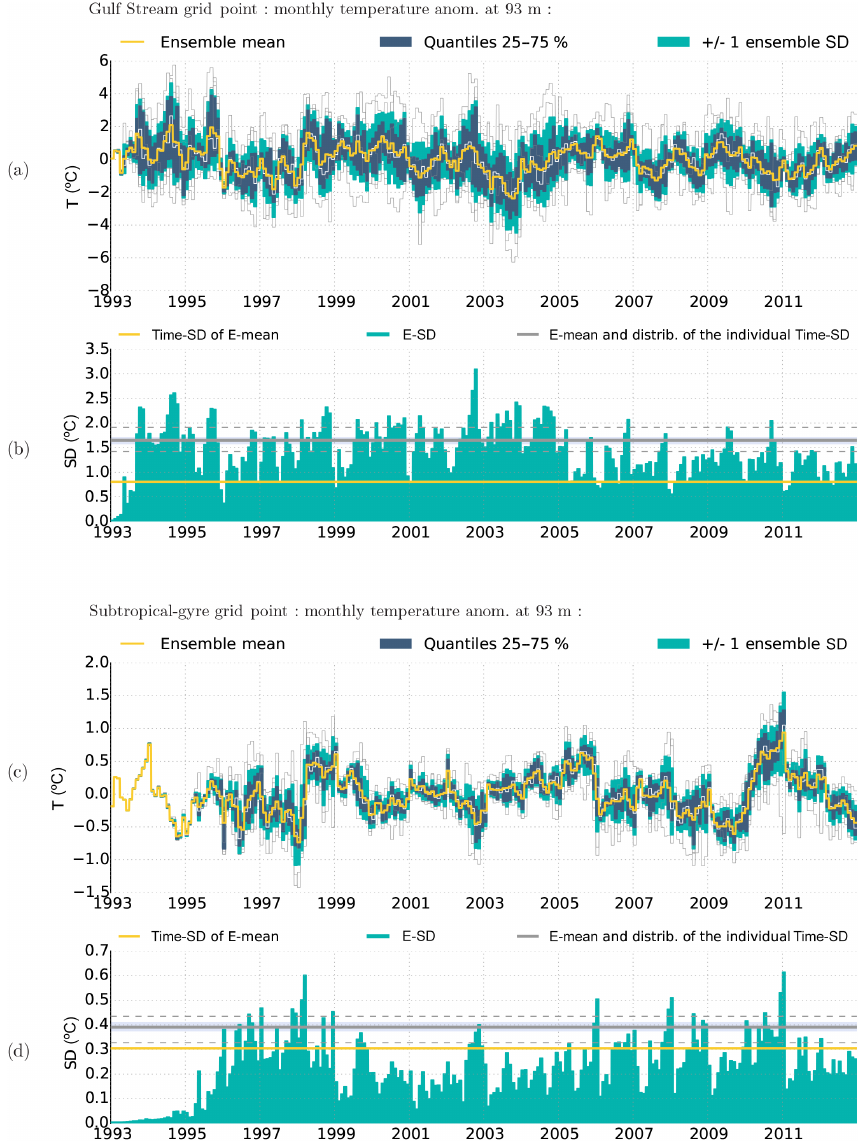
Figure 4. Ensemble statistics of the monthly temperature anomalies from the regional ensemble E-NATL025, at depth 93m at two grid points: (a, b) in the Gulf Stream (42 ◦ N, 56 ◦ W) and (c, d) in the North Atlantic subtropical gyre (22 ◦ N, 42 ◦ W). Anomalies are shown after detrending and seasonal cycle removed (see text for details). (a) The individual trajectories with time of the 10 members appear in thin grey. E-mean is in thick yellow, the interval between quantiles Q1 (25%) and Q3 (75%) is filled in dark blue, and the interval E-mean filled in green. (b) E-SD (intrinsic variability, green shading) is compared to the Time-SD of E-mean (forced variability, thick yellow line). Also shown in (b) is the distribution of Time-SD for the 10 members: ensemble mean of the Time-SDs (solid grey), minimum and maximum (dashed grey), and mean 1 ensemble standard deviation (pale blue ±